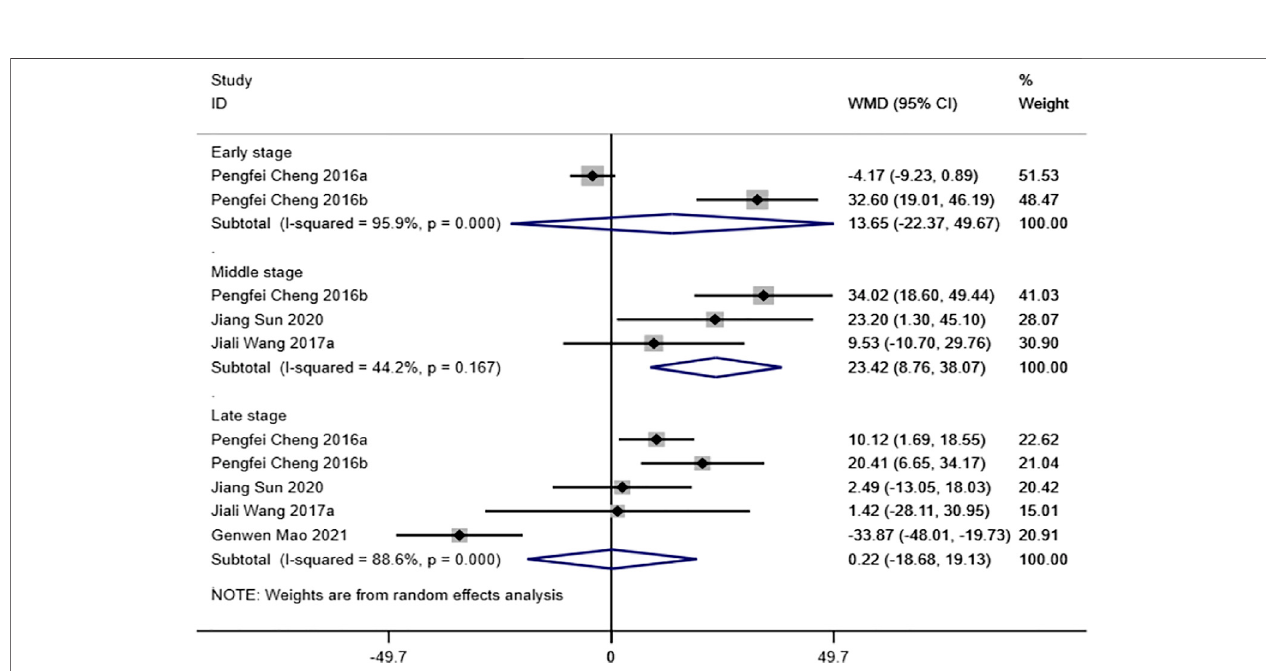
FIGURE 4 | Meta-analysis results of ultimate load to failure of magnesium and its alloys vs. titanium and its alloys.